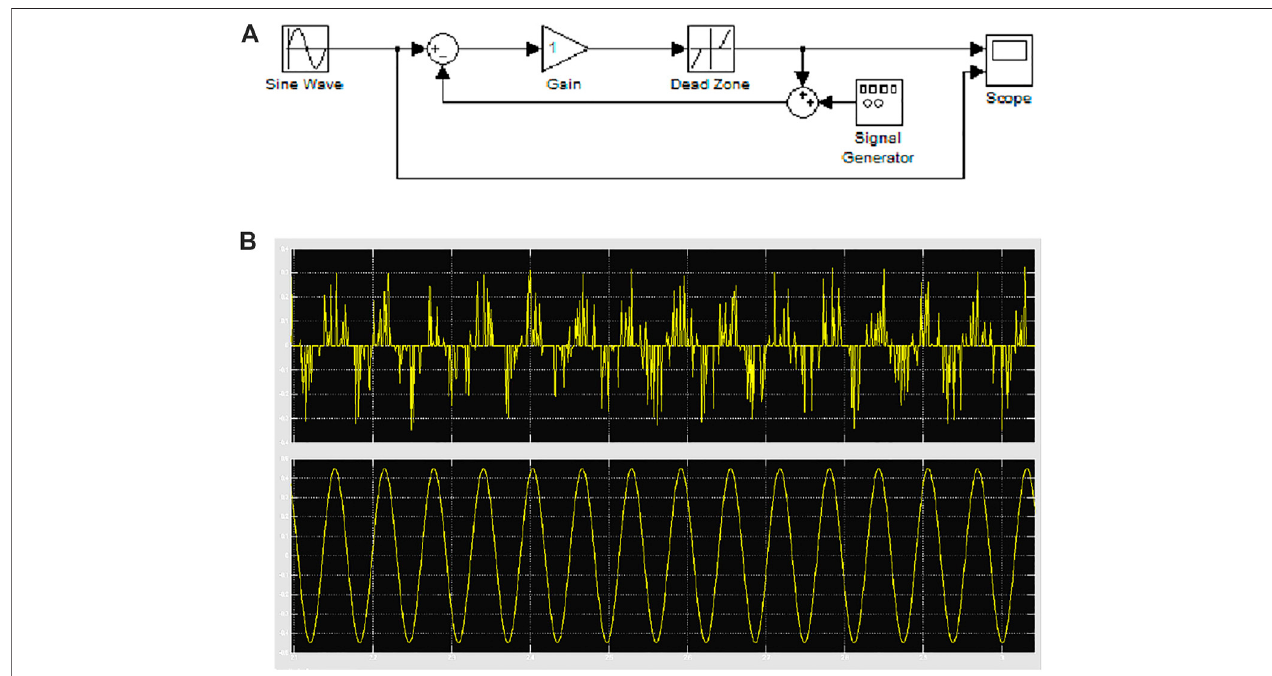
FIGURE 8 | Stochastic resonance in nonlinear systems. (A) Closed-loop system with the inclusion of feedback noise. (B) The subthreshold input signal (lower panel) can be retrieved at the output of the closed-loop system (higher panel) when a suitable amount of noise is included.